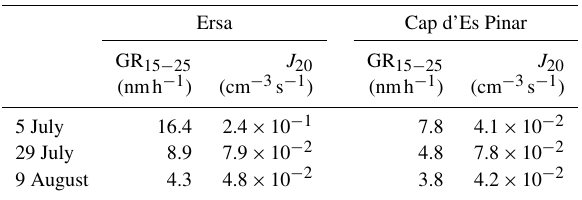
Table 3. Average growth rates and formation rates computed for the three case studies at Ersa and Cap d’es